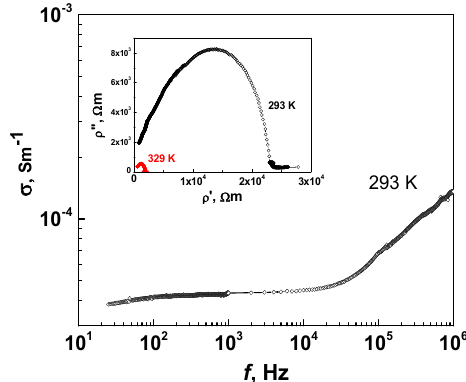
Figure 13. Frequency dependence of specific conductivity along [011] in MBI-phosphate-2 at temperatures of T = 293 and 329 K. Inset shows Cole–Cole plot of complex resistivity.